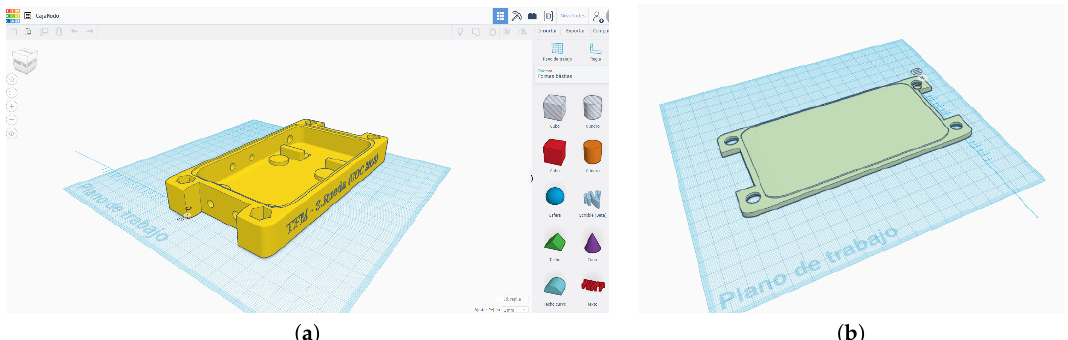
Figure 7. 3D design of the waterproof case. ( a ) The whole case. ( b ) The cover.